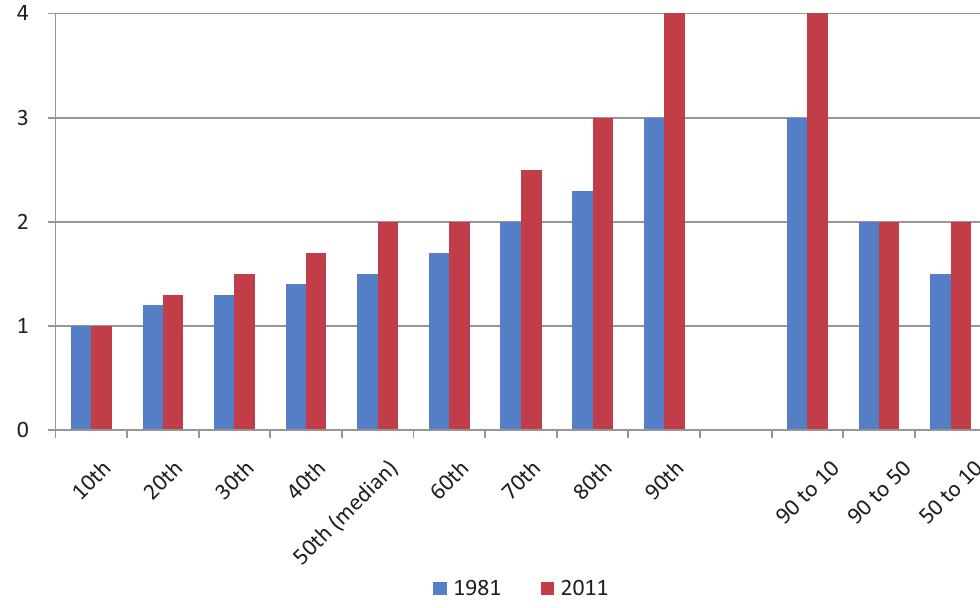
Figure 4. Housing space in rooms per person in England and Wales by percentile and ratios between percentiles, 1981 and 2011. Compiled by the author based on data from Casweb for 1981 and Nomisweb for